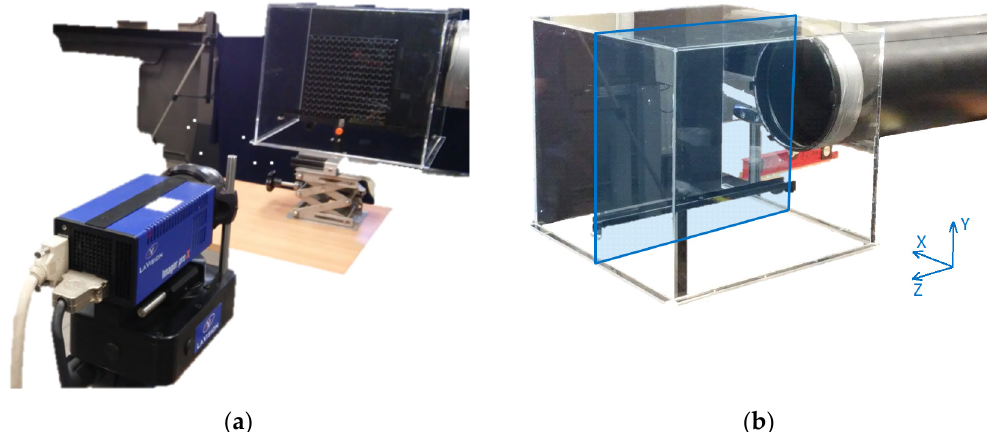
Figure 3. The tested plenum box with ( a ) the calibrated plate; ( b ) the marked plane Z-Y on which measurements were taken.